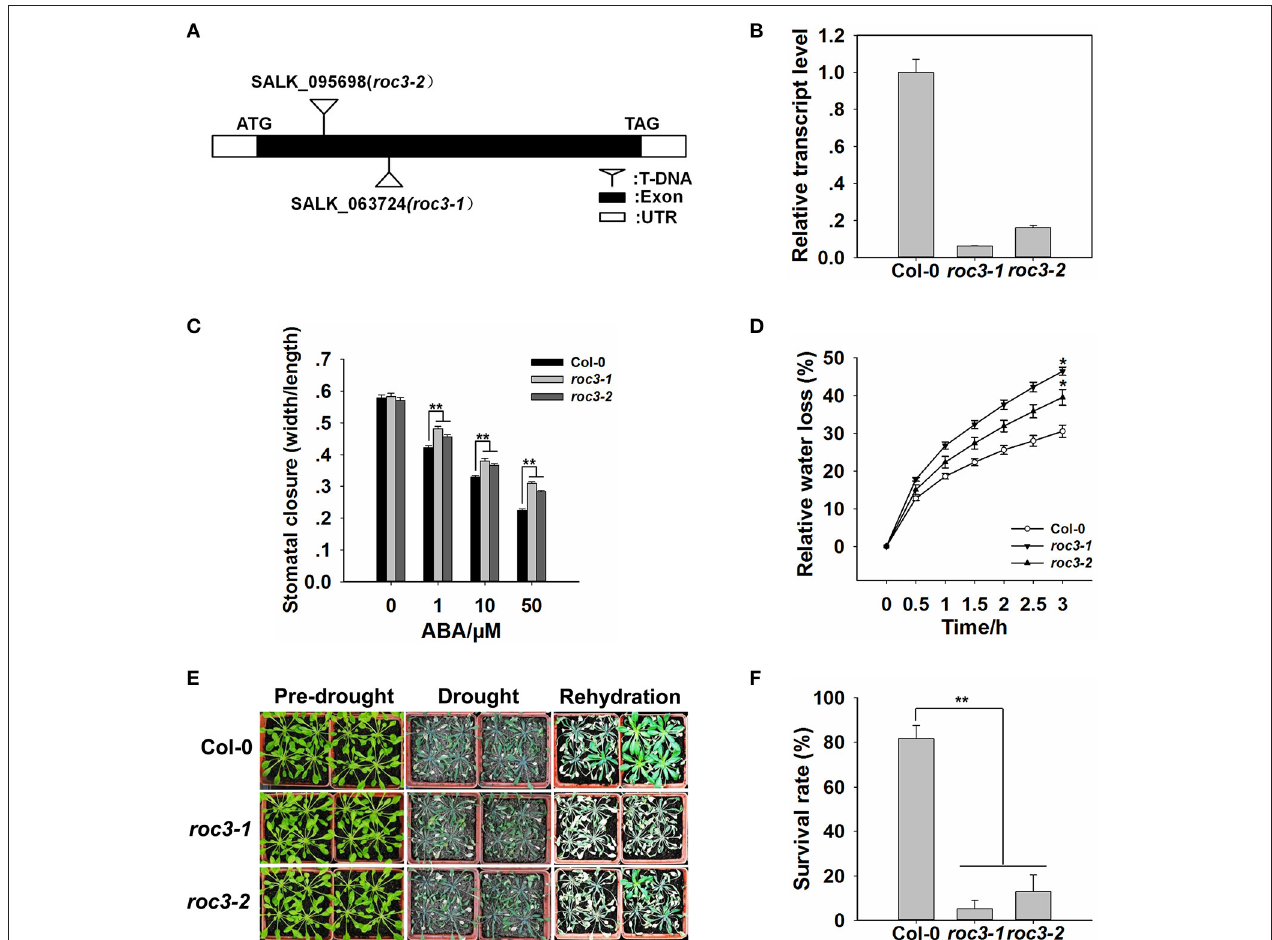
FIGURE 2 | Stomatal closure in ROC3 knock-down mutants is induced by exposure to ABA and the plants exhibit a lesser level of drought tolerance. (A) The T-DNA insertion points in the two independent roc3 mutants. (B) Relative ROC3 transcript abundances assessed using qRT-PCR in WT and roc3 seedlings. Values shown in the form mean ± SE ( n = 3). (C) ABA-induced stomatal closure, as quantified by the stomatal width/length ratio measured in at least 60 stomata per genotype per replicate. Error bars represent the SE ( n = 60), **: means differed significantly from WT ( P < 0.01). (D) The rate of water loss from detached rosette leaves of WT and roc3 mutants. Values shown in the form mean ± SE ( n = 3), *: means differed significantly from WT ( P < 0.05). (E) The appearance of WT and roc3 mutant plants grown under conditions of drought stress. (F) The survival rate of WT and roc3 mutant plants grown under conditions of moisture stress. Data are shown as means ± SE ( n =